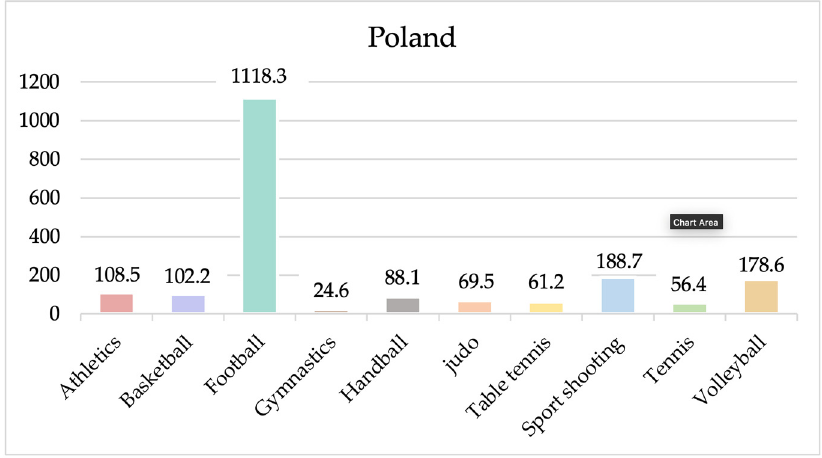
Figure 2. Registered athletes per 100,000 inhabitants: Poland; Source: (Statistics Poland 2022). More than half of the registered athletes are involved in football, with a difference of up to 929 athletes per 100,000 inhabitants compared to the second sport, shooting. Then the differences in the list are less pronounced, which indicates that football is of the greatest interest in this country from the perspective of the country’s registered athletes.